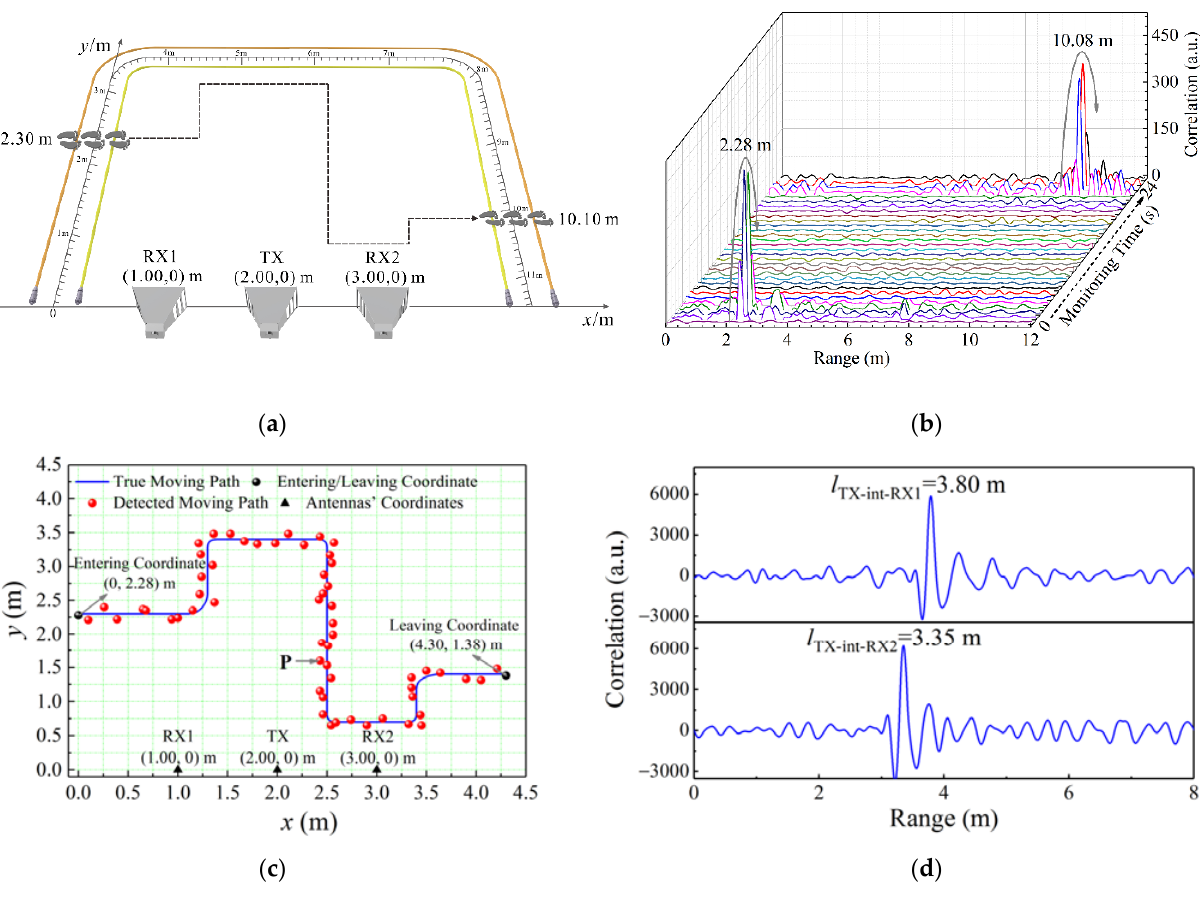
Figure 7. ( a ) Intrusion process, and the detection results of ( b ) early alarm, ( c ) path tracking, and ( d ) ranging at position P. ( d ) ranging at position